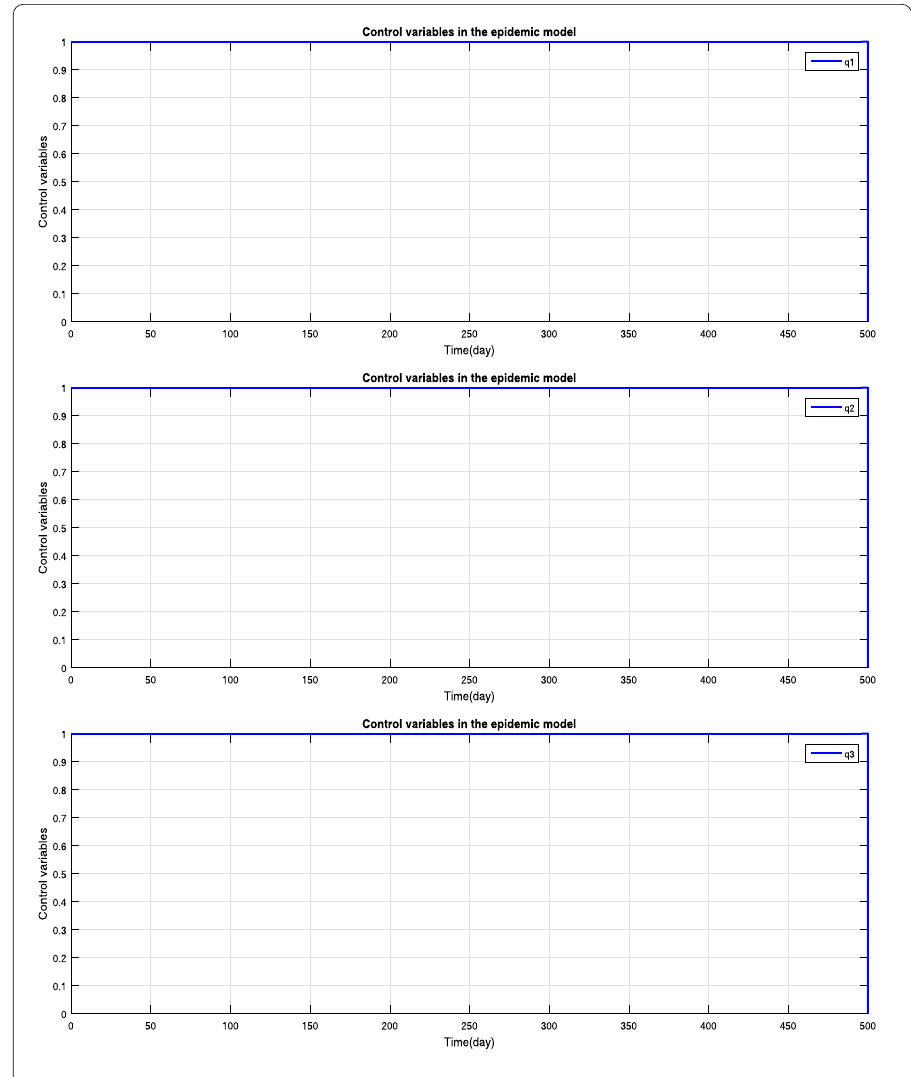
Figure 13 Control variables q 1 , q 2 , and q 3